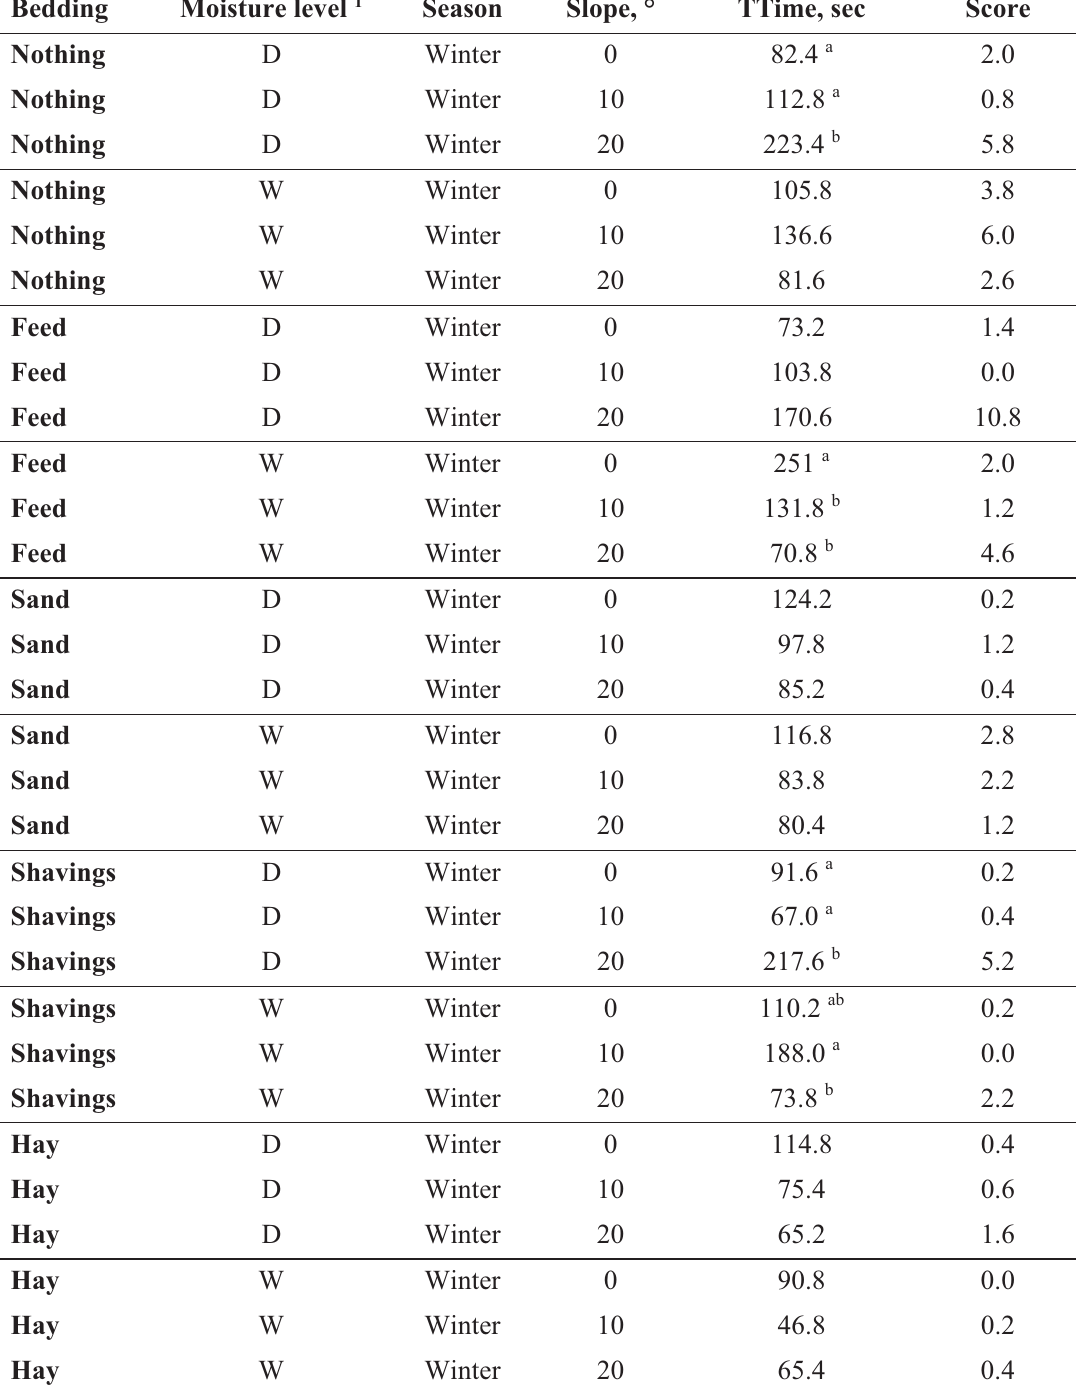
Least Squares means accompanied by a different superscript differ ( P < 0.05) within a bedding, moisture level, and season. 1 Moisture levels: dry (D); wet